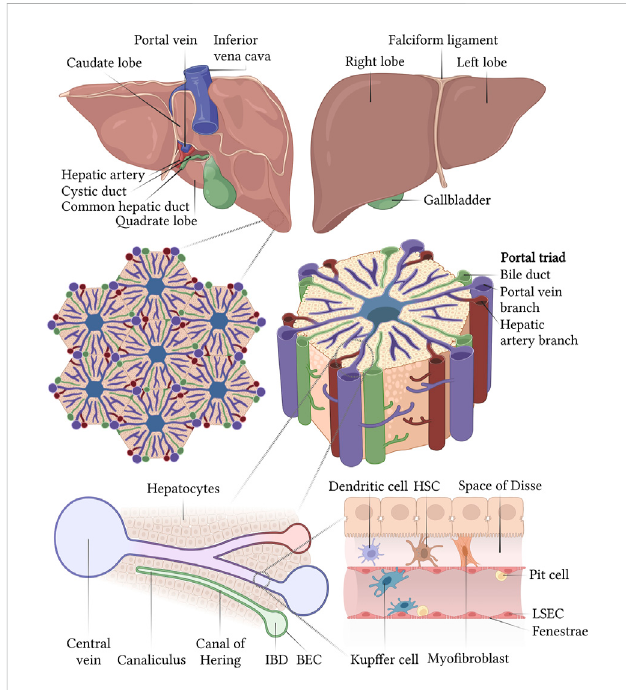
FIGURE 2 Structural organizationoftheliveratdifferentscales andschematic representation of a liver sinusoid. Created with